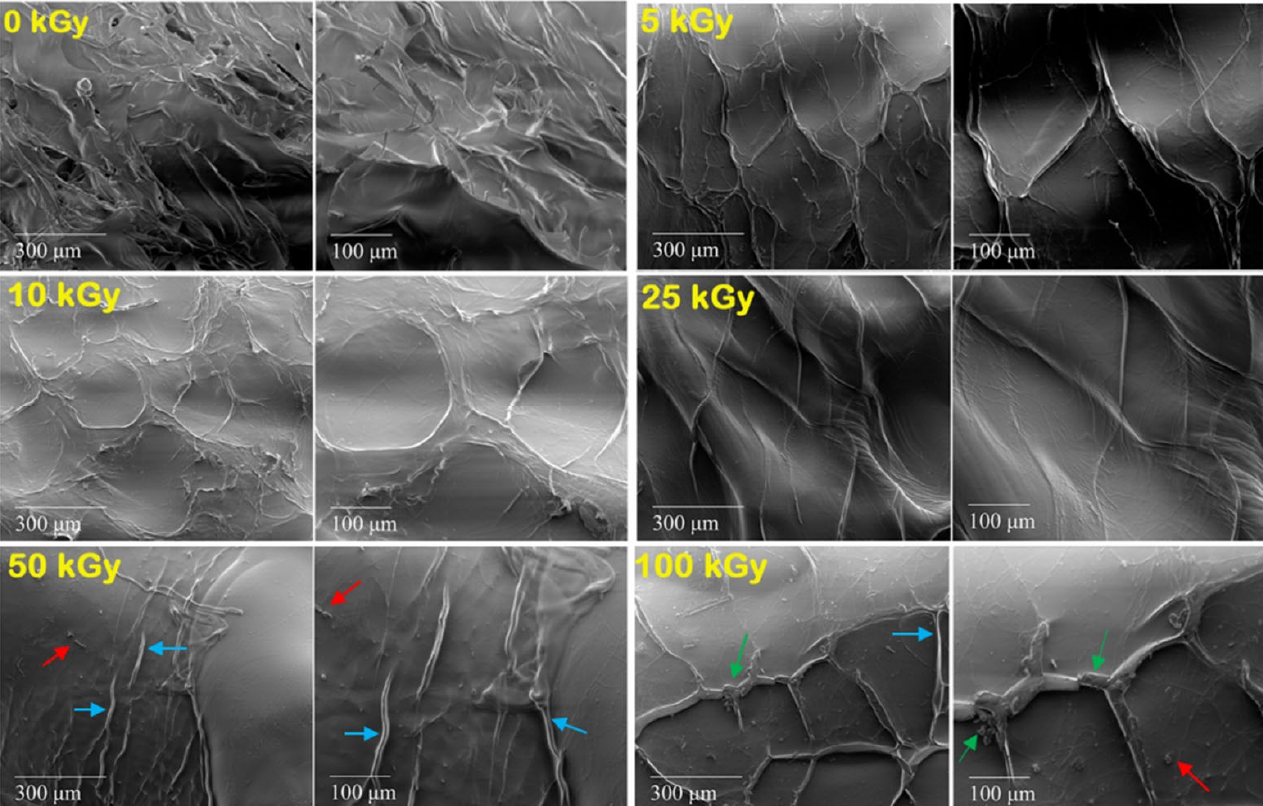
Figure 5. SEM images of non ‐ crosslinked and crosslinked collagen hydrogels. The prominent striations, small fragments of collagen fibers, and fine cracks are marked with arrows.